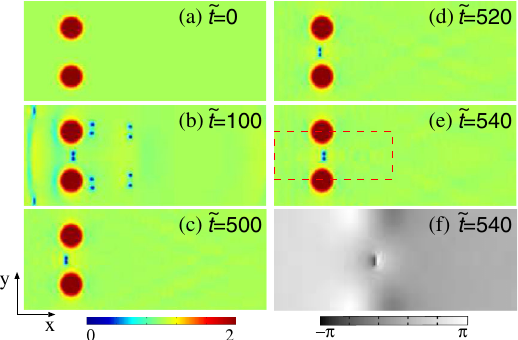
pro- 0 Þ ¼ (cid:2) 5 , v=v ¼ = ð gn 0 0 s